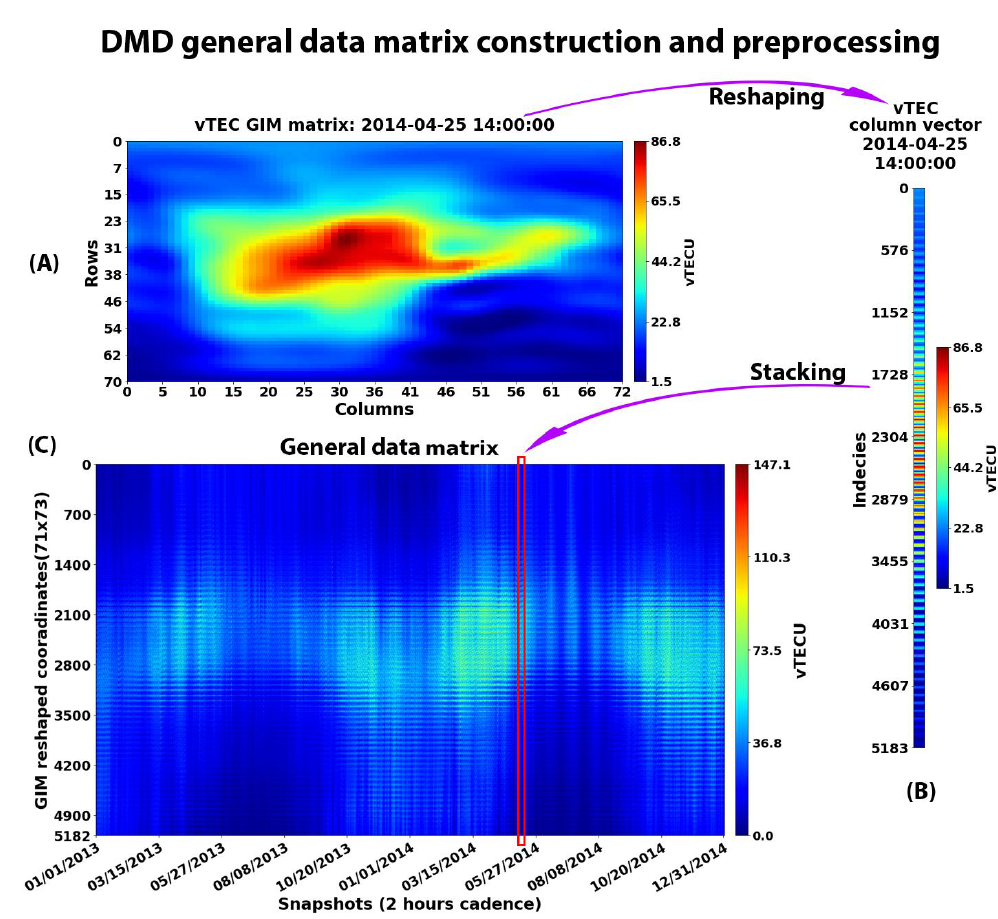
Figure 3. DMD general data matrix construction and preprocessing illustration. ( A ) represents an IGS vTEC GIM for 25-04-2014 at 14:00. ( B ) is a reshaped vTEM GIM into a column vector. ( C ) represents the full data-set matrix stacked from the IGS column vectors.